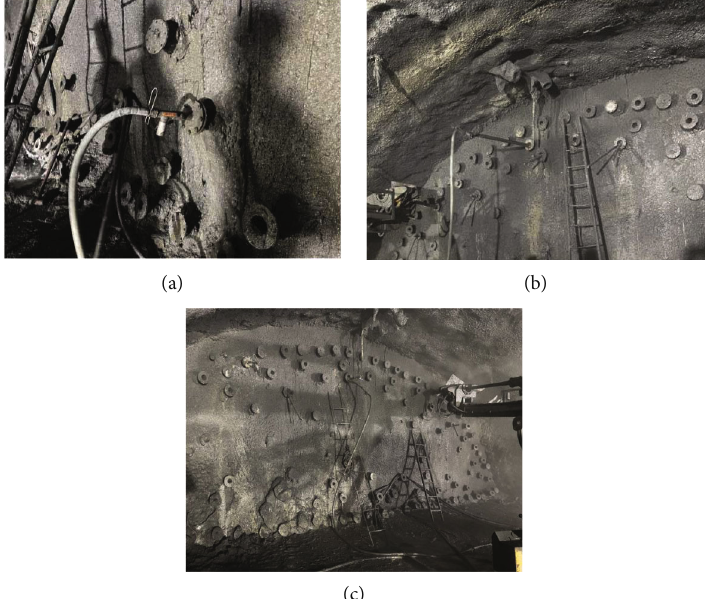
Figure 12: Grouting technology: (a) Forward Segmental Grouting, (b) Backward Segmental Grouting, and (c) Cluster Cu ff Tube